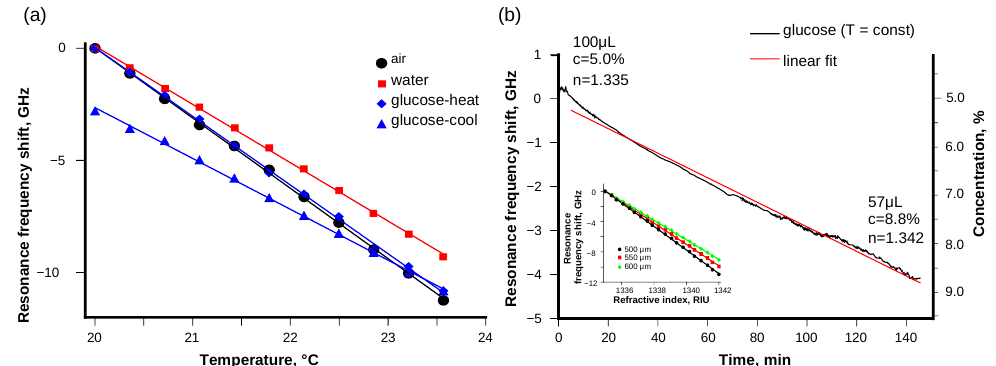
Figure 3. The frequency shifts depending on temperature for WGMR ( a ) in air, water, and 5% glucose solution are linear and can be fitted with linear approximations; however, for glucose, the frequency shift is different when heating or cooling. Therefore, it consists of two separate parts: ( b ) the independent shift of resonance spectra for a 5% glucose solution in stable temperature, and the drop evaporates and the glucose concentration increases, which changes the refractive index. Inset shows the modeling results for the resonance frequency shift depending on the refractive index of the surrounding media for 500, 550, and 600 µ m